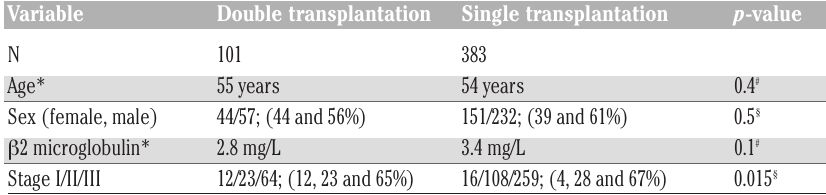
Table 1. Base-line characteristics of the patients according to treatment group.